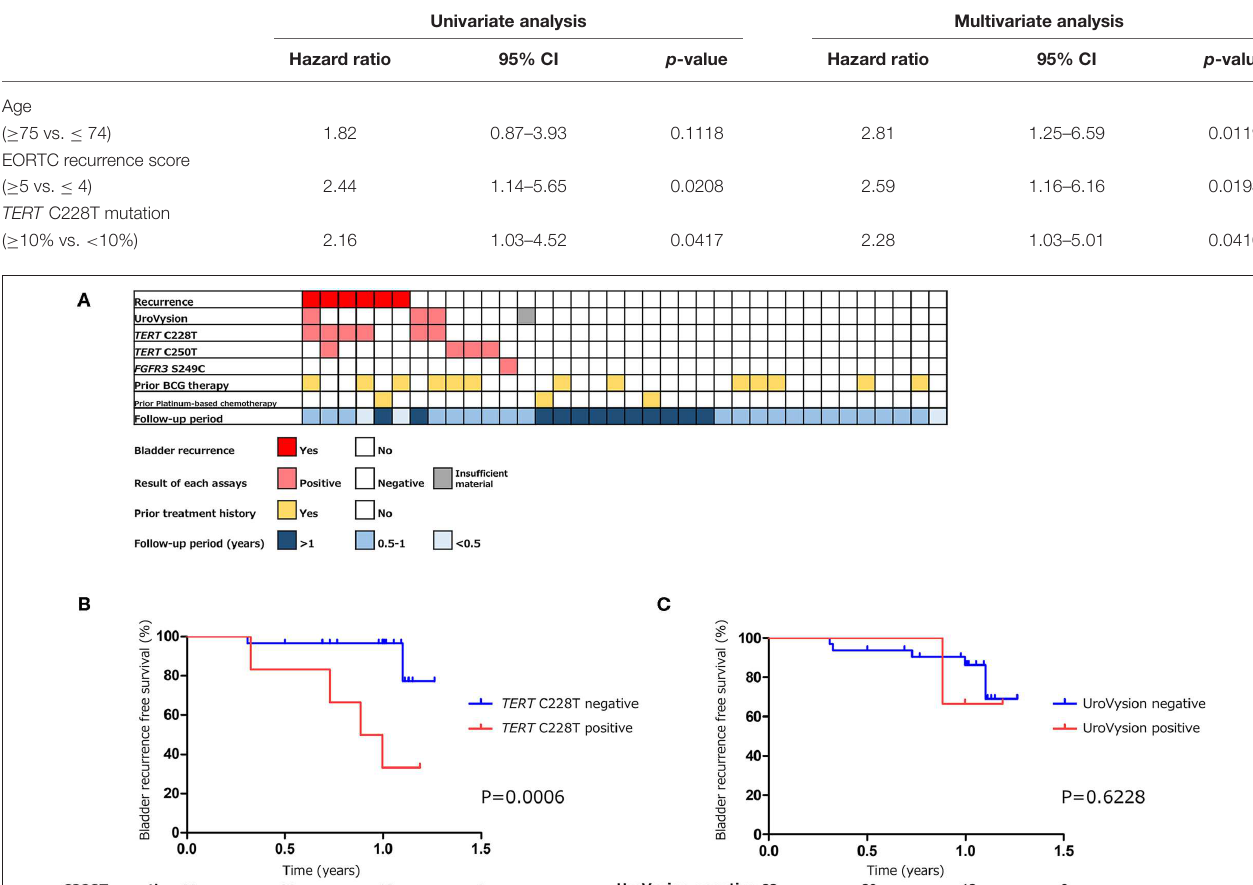
TABLE 3 | Univariate and multivariate analysis of factors associated with bladder tumor recurrence.